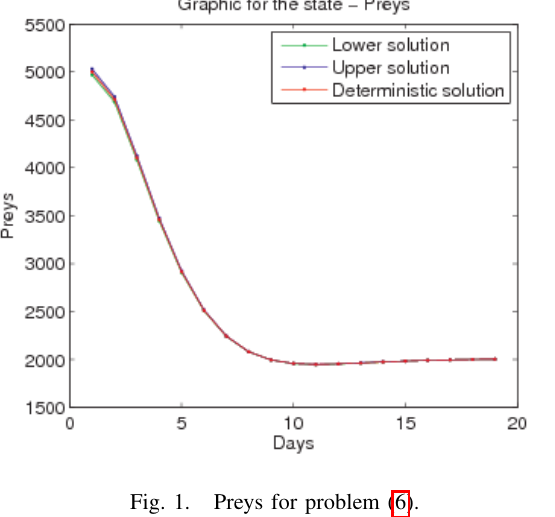
Fig. 1. Preys for problem (6). Fig. 2. Predators for problem (6).